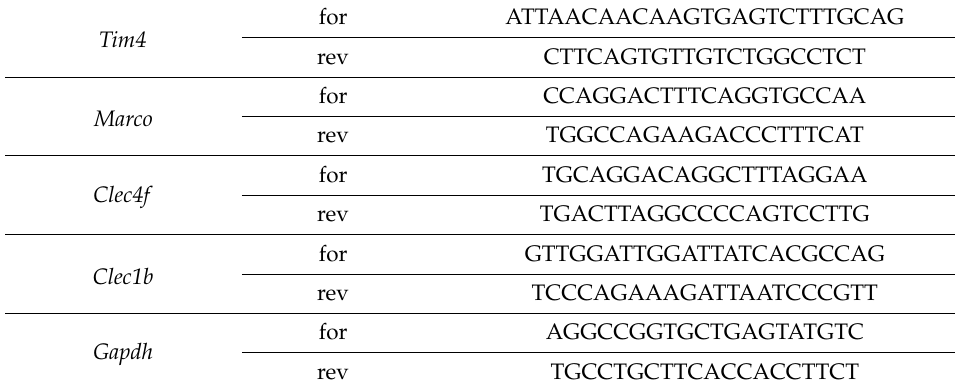
Table 1. PCR primers for the mRNA